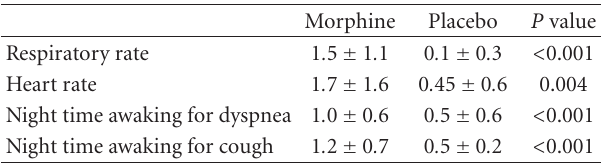
Table 1: Comparison of dyspnea, cough, and quality of life within and between two groups. Group Before Day 1 Day 2 Day 3 Day 4 Day 5 P value Morphine 6 . 9 ± 1 . 1 Dyspnea Morphine 5 . 8 ± 1 . 8 Cough Quality of Morphine 4 . 5 ± 1 . 3 life